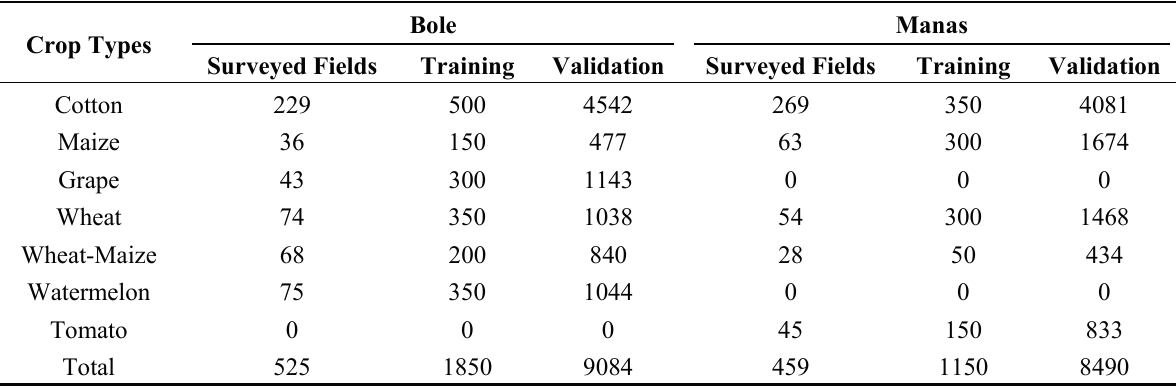
Table 3. Number of surveyed fields, training samples and validation